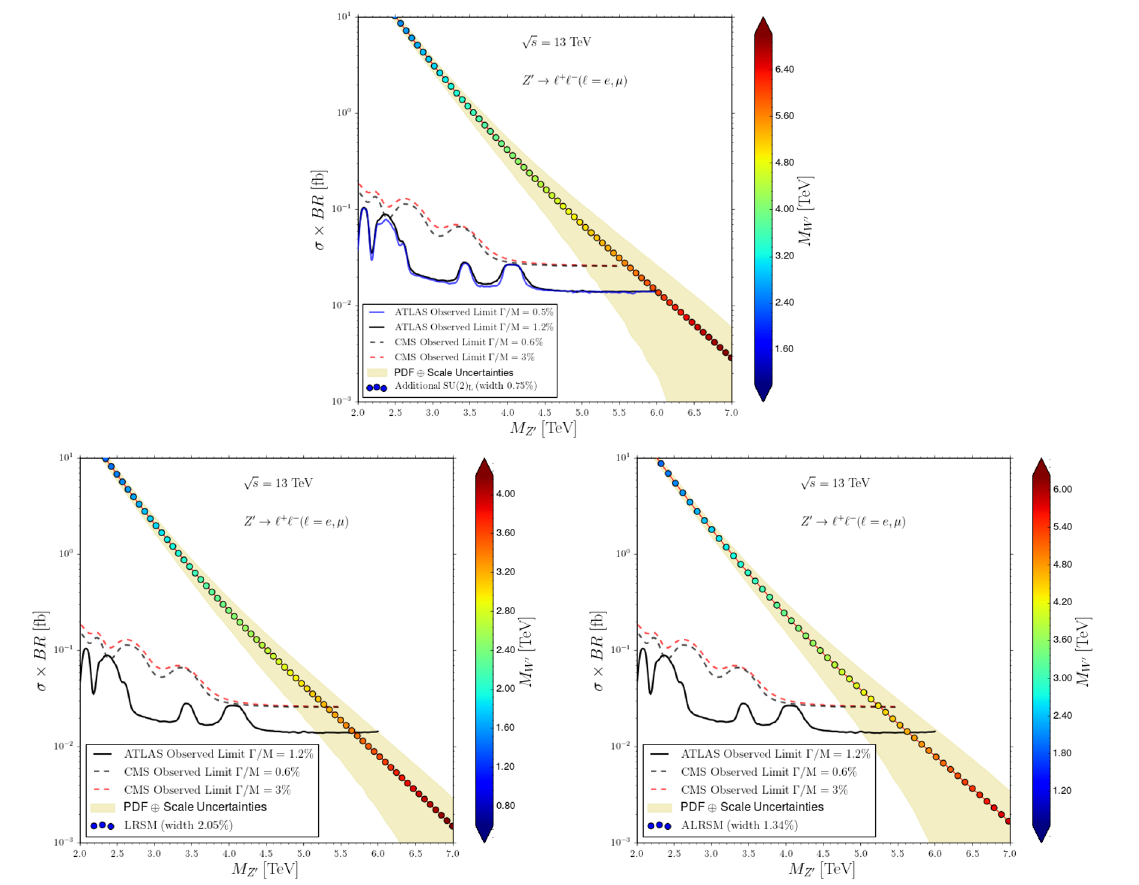
Figure 3 . Same as in figure 1 but for individual models considered separately. We display results for BSM setups with an additional SU(2) L symmetry (top row), and for the LRSM (bottom left) and ALRSM (bottom right). Our predictions are provided together with the associated PDF and scale uncertainties given as shaded areas, and the colour code associated with each Z 0 mass choice refers to the mass of the accompanying W 0